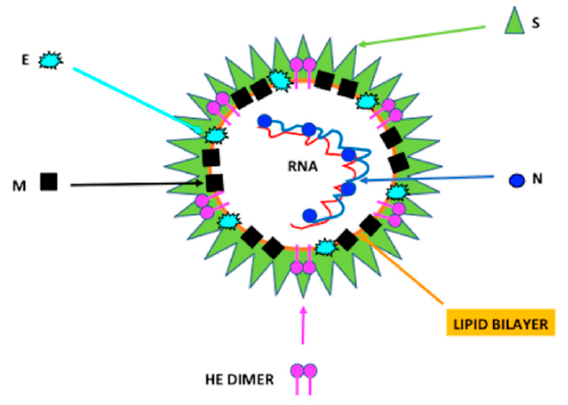
Figure 1. Characteristics of coronavirus.